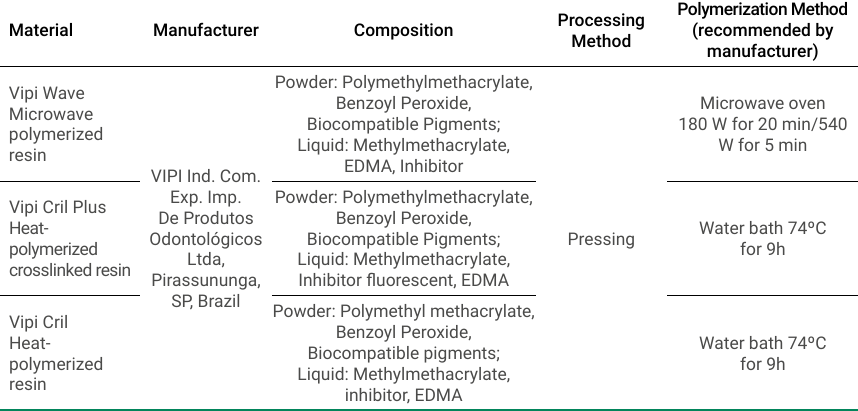
Table 1. Acrylic resins for denture base used in the study and their respective characteristics. Material